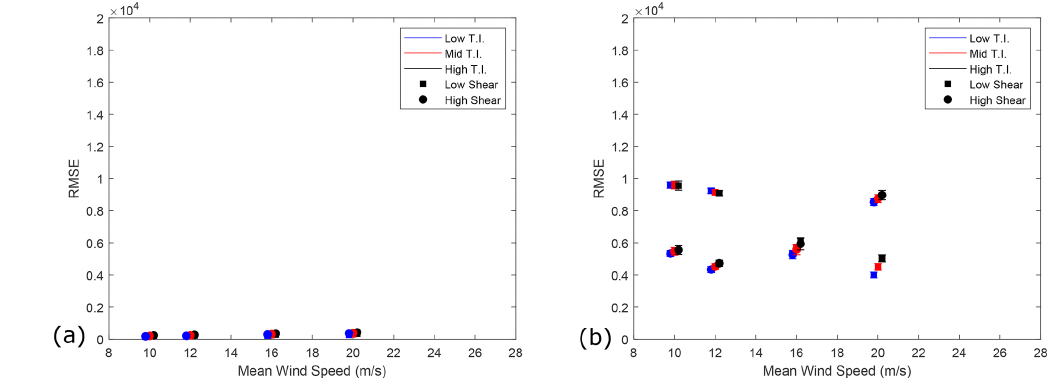
Figure 16. (a) RMSE between reaction forces from the analytical DTRB (with torsional springs) and DTRB FE model in the horizontal plane . The mean and standard deviations within each CPLS are plotted, staggered about mean wind speed for clarity. (b) RMSE reaction force results between the analytical DTRB (with torsional springs) and DTRB FE model in the vertical plane . The mean and standard deviations within each CPLS are plotted, staggered about mean wind speed for clarity.